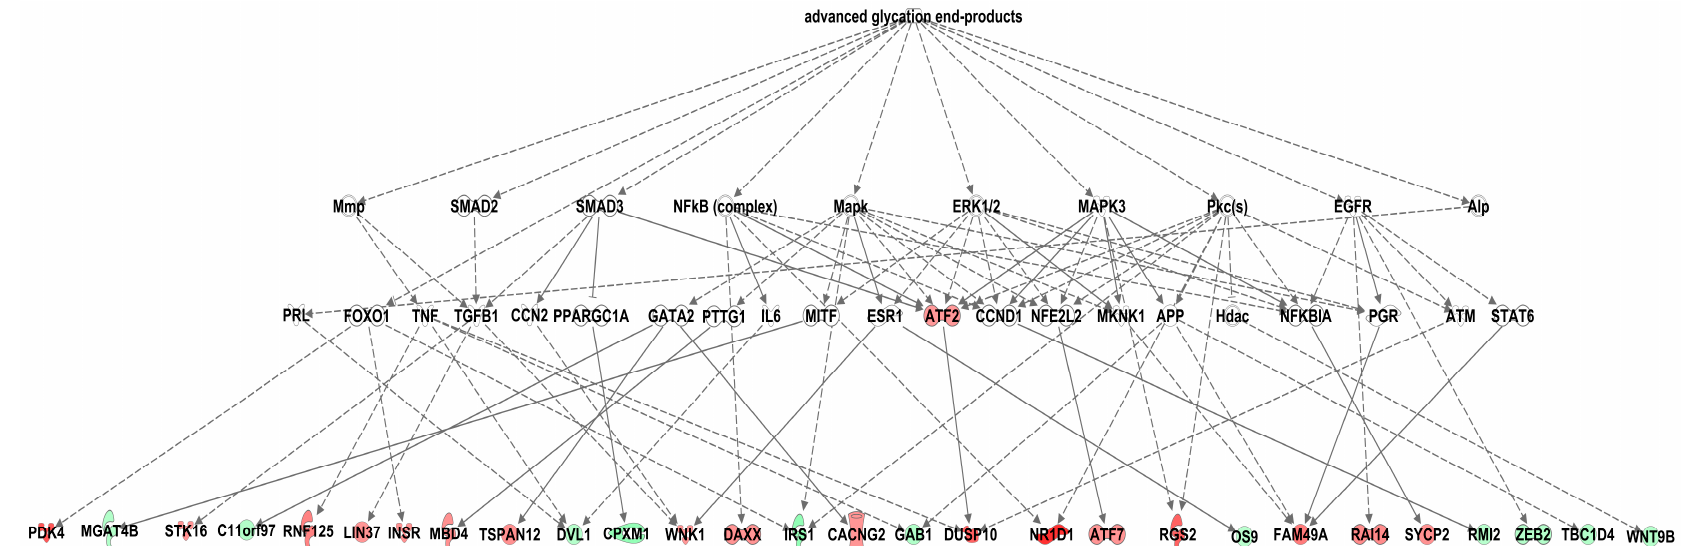
Figure 4. Highest-scoring Causal Network connecting multiple levels of upstream regulators to the significantly differentially expressed genes in white adipose tissue of MG-treated HHTg (hereditary hypetriglyceridaemic) male rats compared to controls. The effect of MG (methylglyoxal) on expression is shown in shades of green (downregulation) or red (upregulation). Full and dashed lines indicate known direct and indirect interactions between the upstream regulator and its downstream target. Derivation of the network was performed using Ingenuity Pathways Analysis.